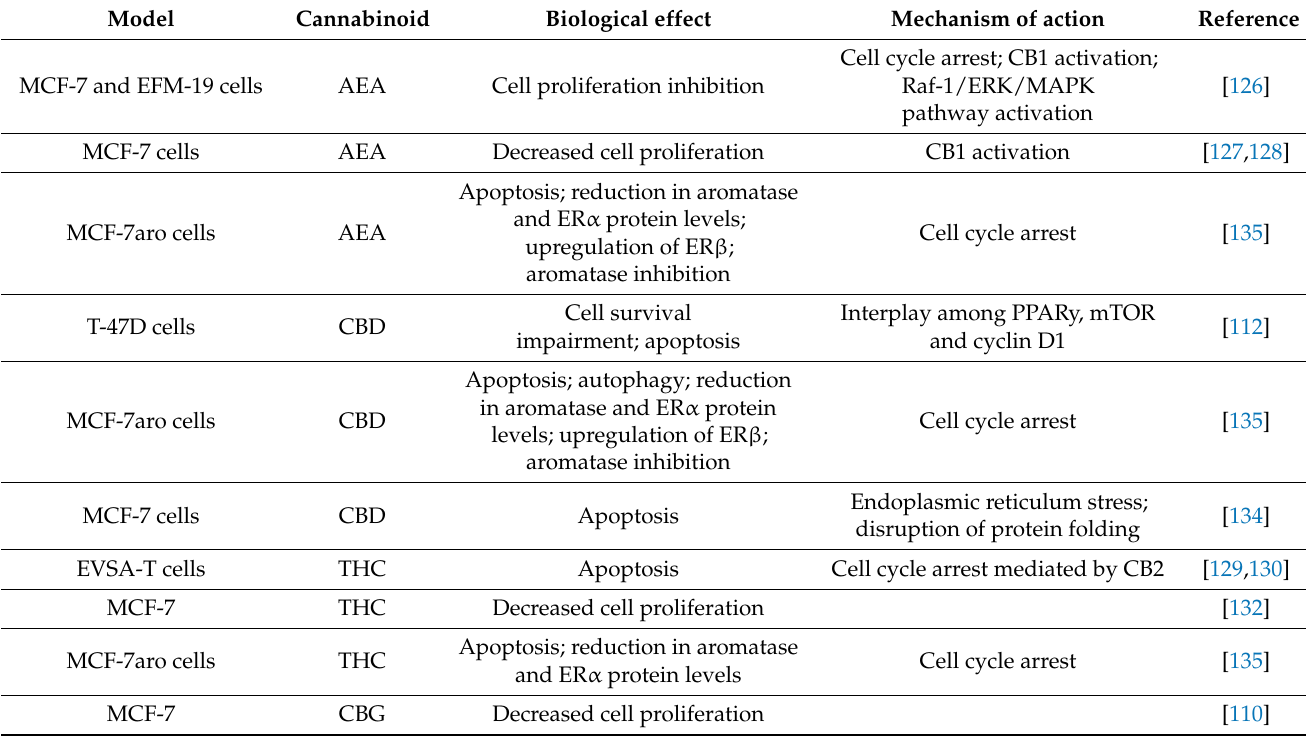
Table 3. Antitumor effects of cannabinoids in ER + breast